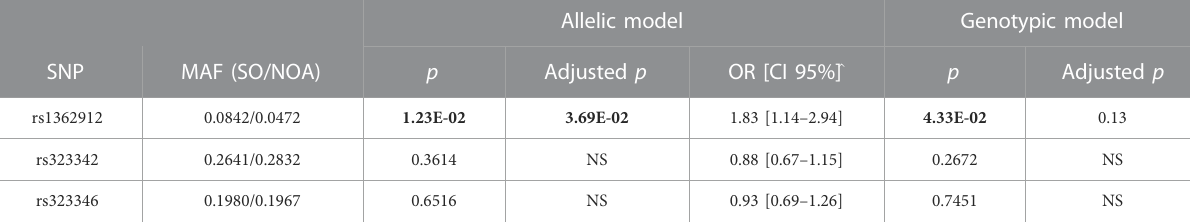
TABLE 2 Analysis of the genotype and allele frequencies of the TEX15 tagger variants comparing the severe oligozoospermia (SO) group against the non- obstructive azoospermia (NOA)